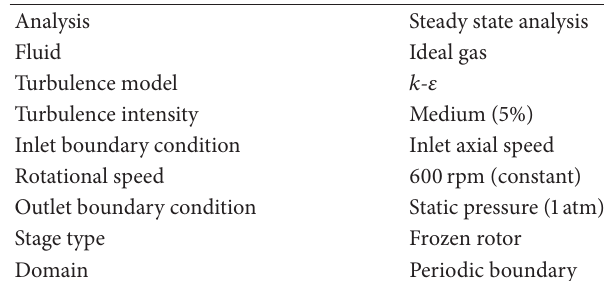
Figure 2: Mesh for rotor. Table 2: Initial and boundary